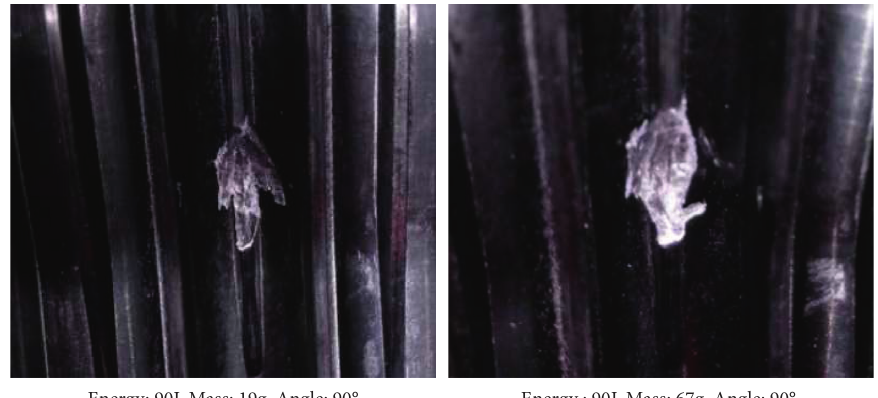
Figure 8: Damage photos of the oil sump after being impacted by 19g and 67g